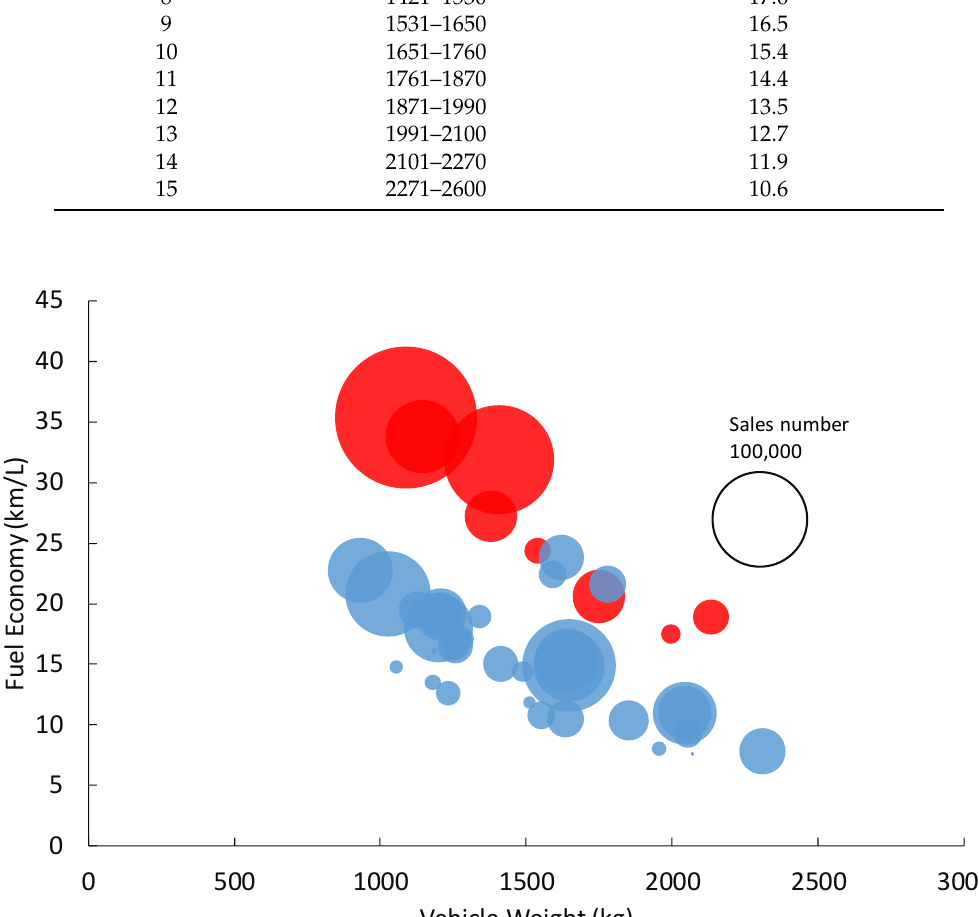
Figure A1. The relationships between fuel efficiency by vehicle model, vehicle weight, and the number of vehicle sales by model for Toyota.